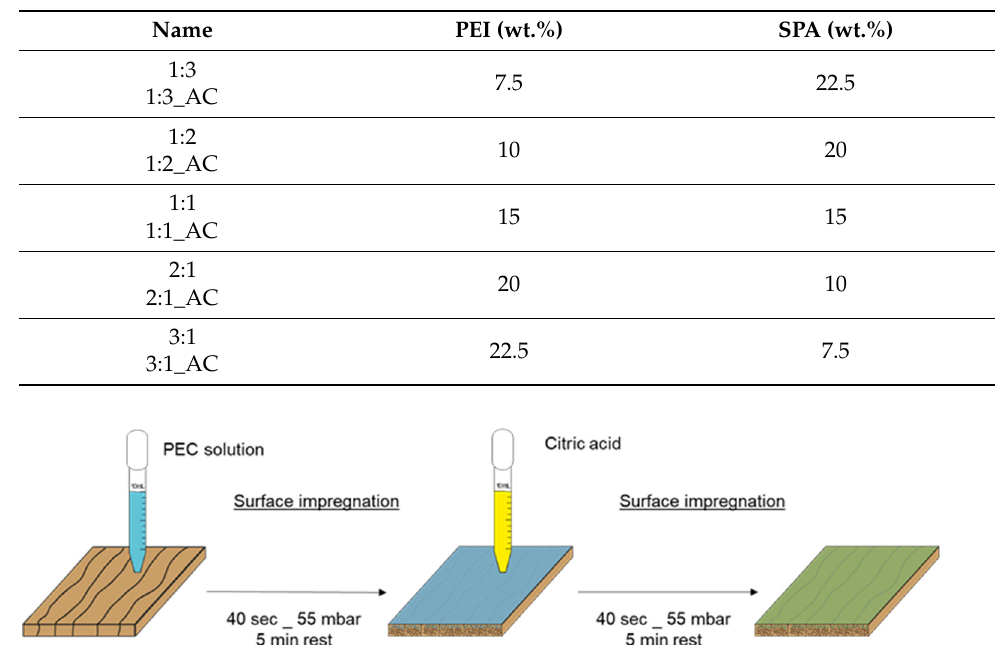
Table 1. Summary of tested polyelectrolyte complex solutions.